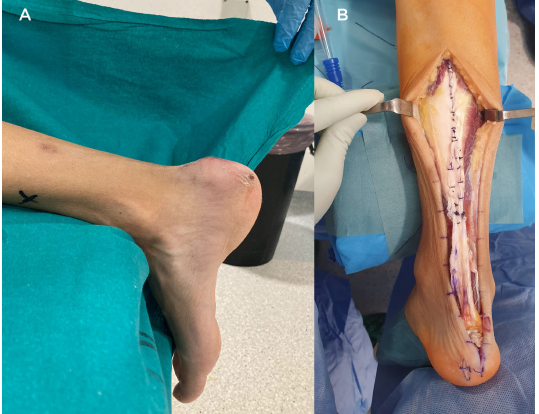
Figure 2. A case of a male patient with a less than 6 cm gap treated with V-Y tendon advancement and FHL transfer. ( A ) Preoperative foot exploration with visible sinking at the Achilles tendon. ( B ) An intraoperative picture with the technique performed: V-Y Achilles tendon advancement plus FHL